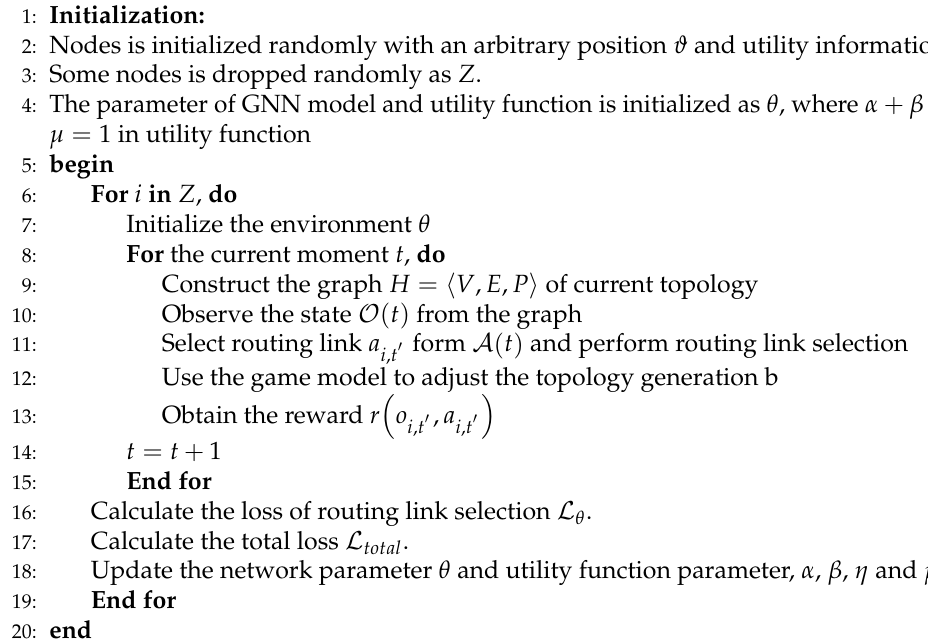
Algorithm 2 DRL Agent